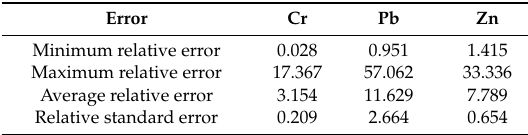
Figure 4. Predicted and measured values of Cr, Pb, and Zn concentrations in wheat in Liuxin mining area. Table 7. Error analysis of predicted values for heavy metals in wheat unit: %.